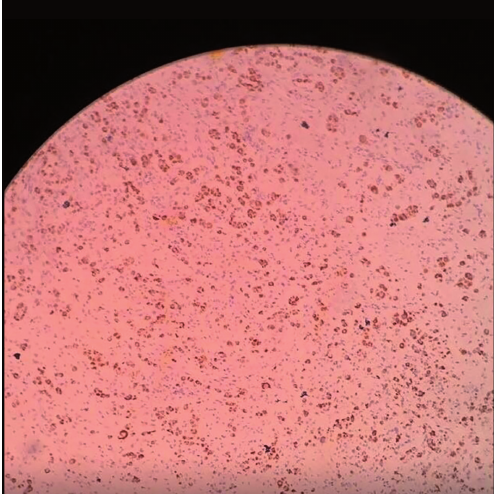
Figure 4 - Inhibin antibody (4x).